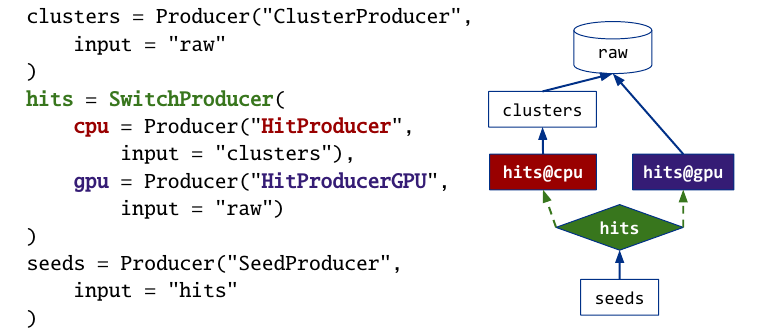
Figure 1. A configuration fragment showing an example of how the SwitchProducer would look like (left), and a data dependence graph corresponding the configuration (right). On the CPU case, the HitProducer depends on a data product clusters , whereas on the GPU case, the HitProducerGPU takes directly raw as an input. The SwitchProducer decides at runtime on the worker node which of the two producers should be